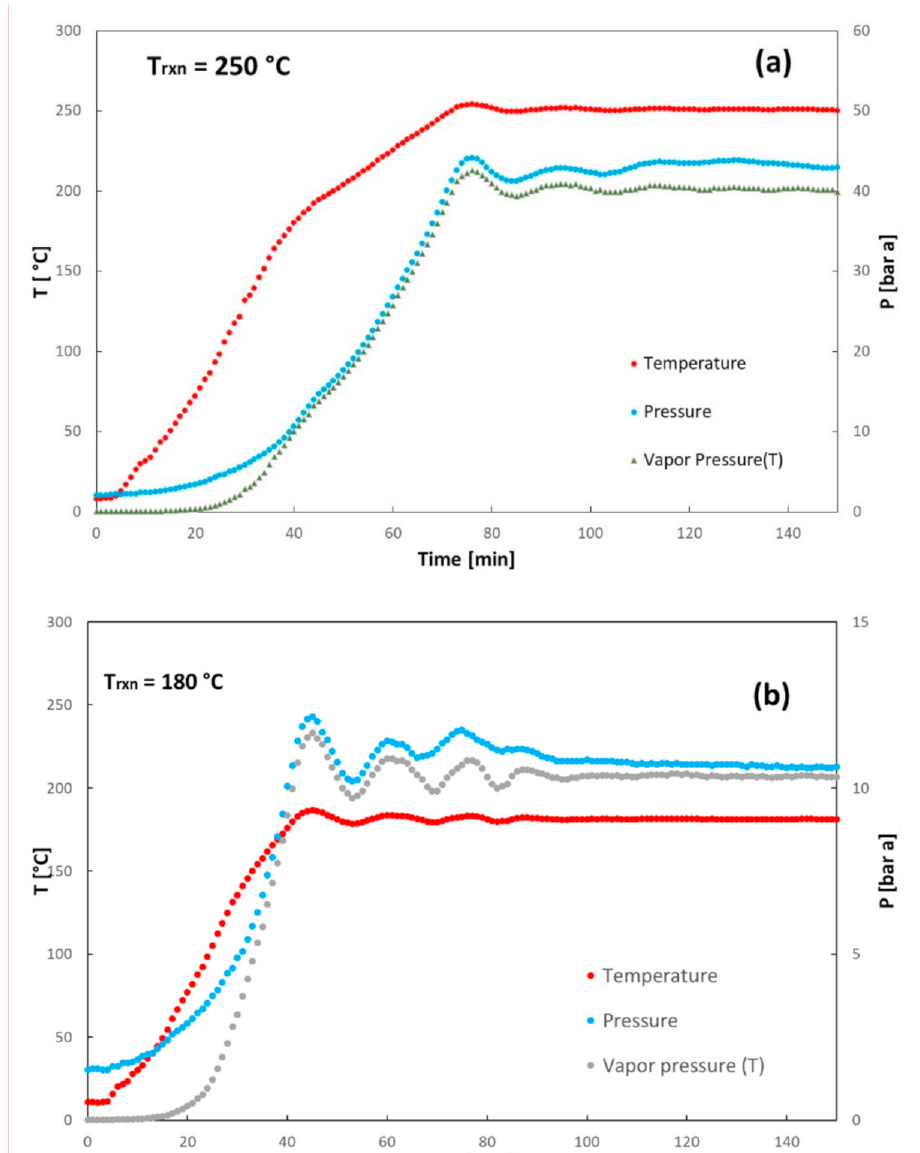
Figure 6. Temperature and pressure time evolution during the heating and HTC production phases: ( a ) reaction temperature 250 ◦ C; ( b ) reaction temperature 180 ◦